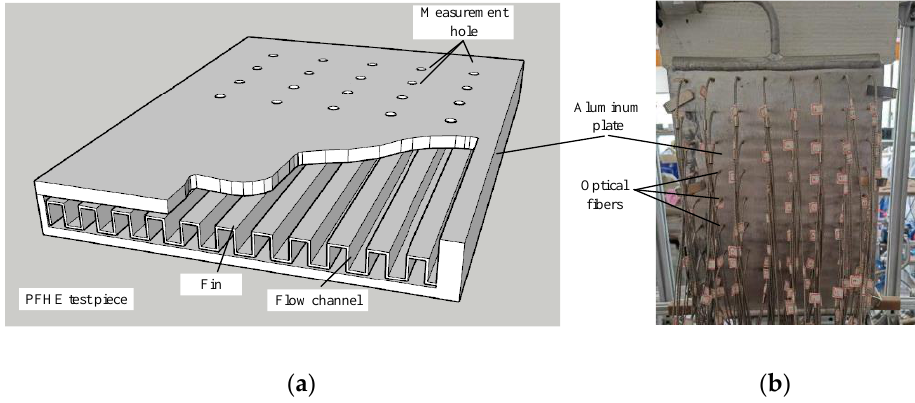
Figure 7. The diagram of the PFHE: ( a ) Structural sketch; ( b ) Practical installation.